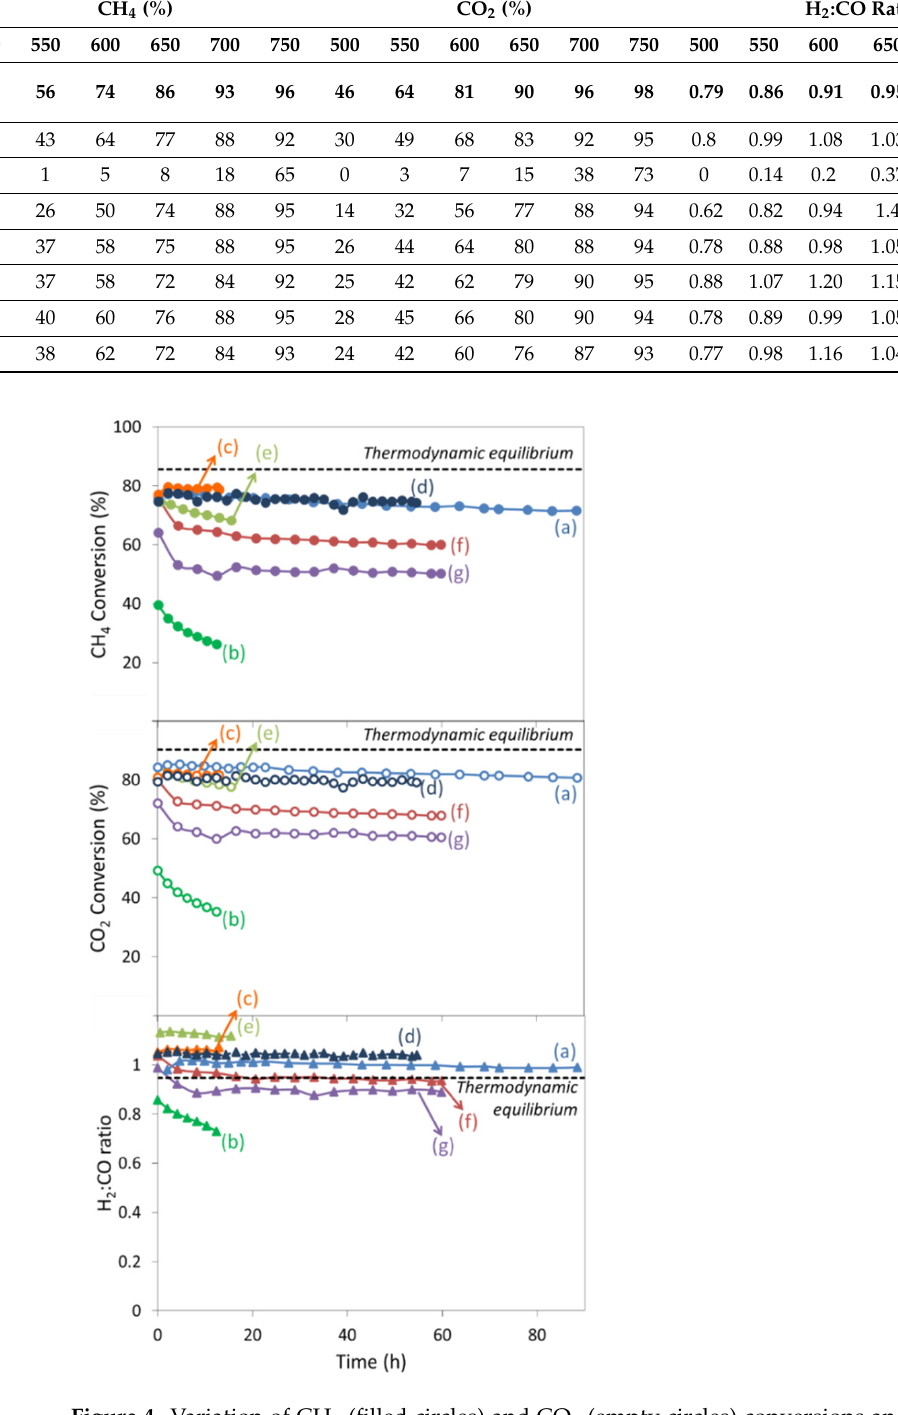
Figure 4. Variation of CH 4 (filled circles) and CO 2 (empty circles) conversions and H 2 :CO molar ratio (triangles) with time at 650 °C (36 L.g − 1 .h − 1 and CH 4 :CO 2 :Ar = 5:5:90) for ( a ) Ni/SBA-15 HT (N), ( b ) Ni/SBA-15 HT (Cl), ( c ) Ni/SBA-15 HT (A), ( d ) Ni/SBA-15 HT (R), ( e ) Ni/SBA-15(N), ( f ) Ni/SBA- 15 com (N), and ( g ) Ni/SiO 2 (N).